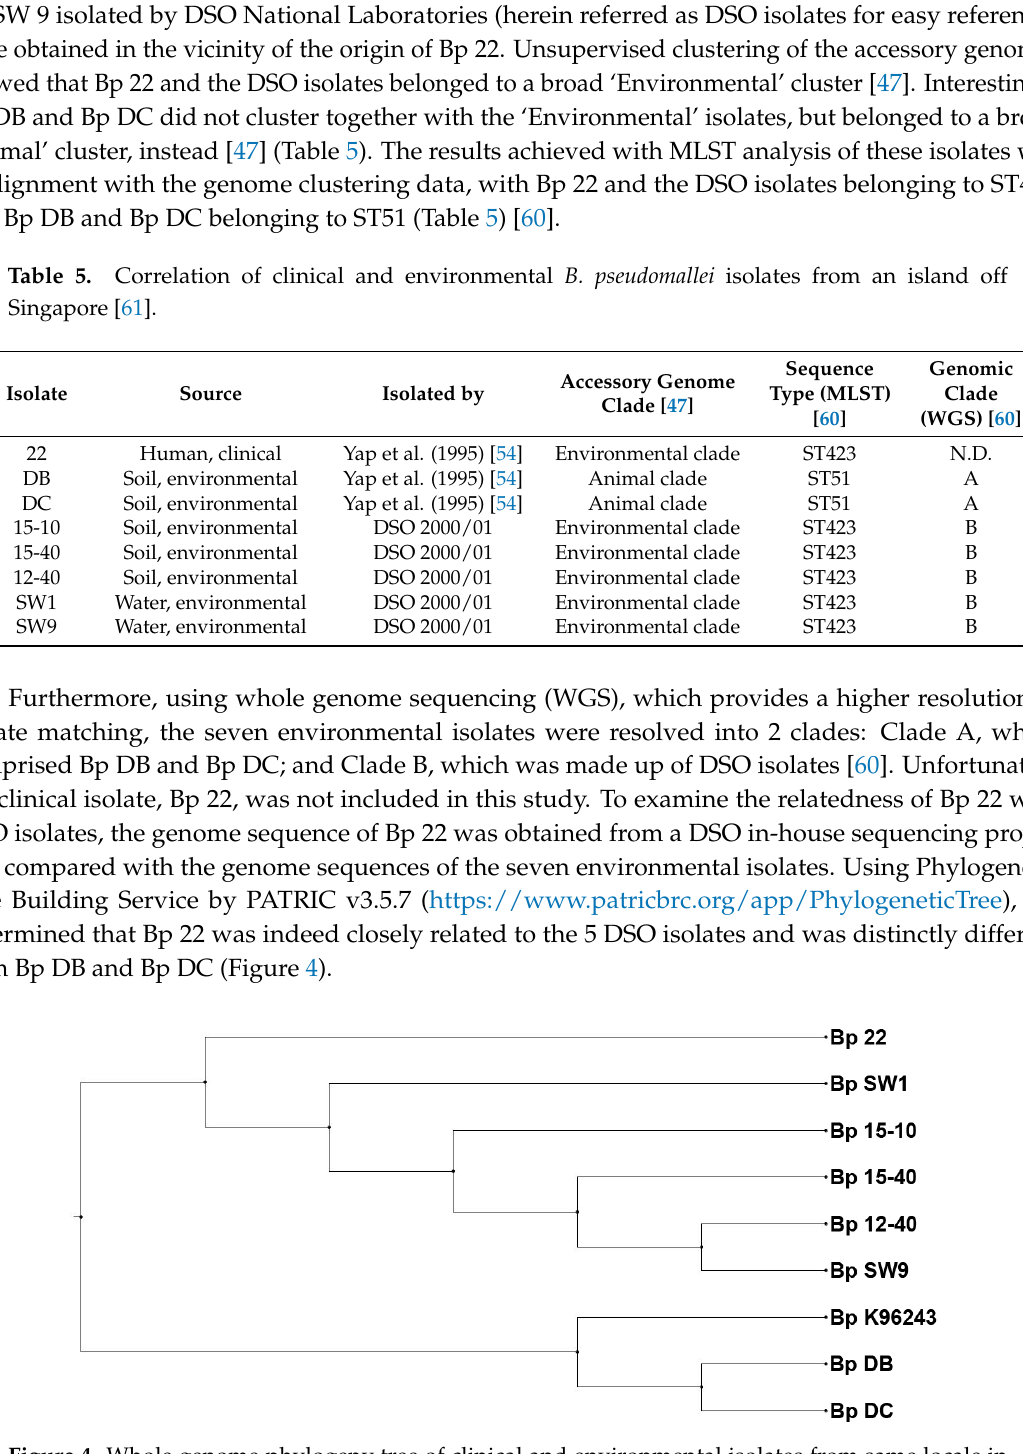
Table 5. Correlation of clinical and environmental B. pseudomallei isolates from an island off Singapore [61].